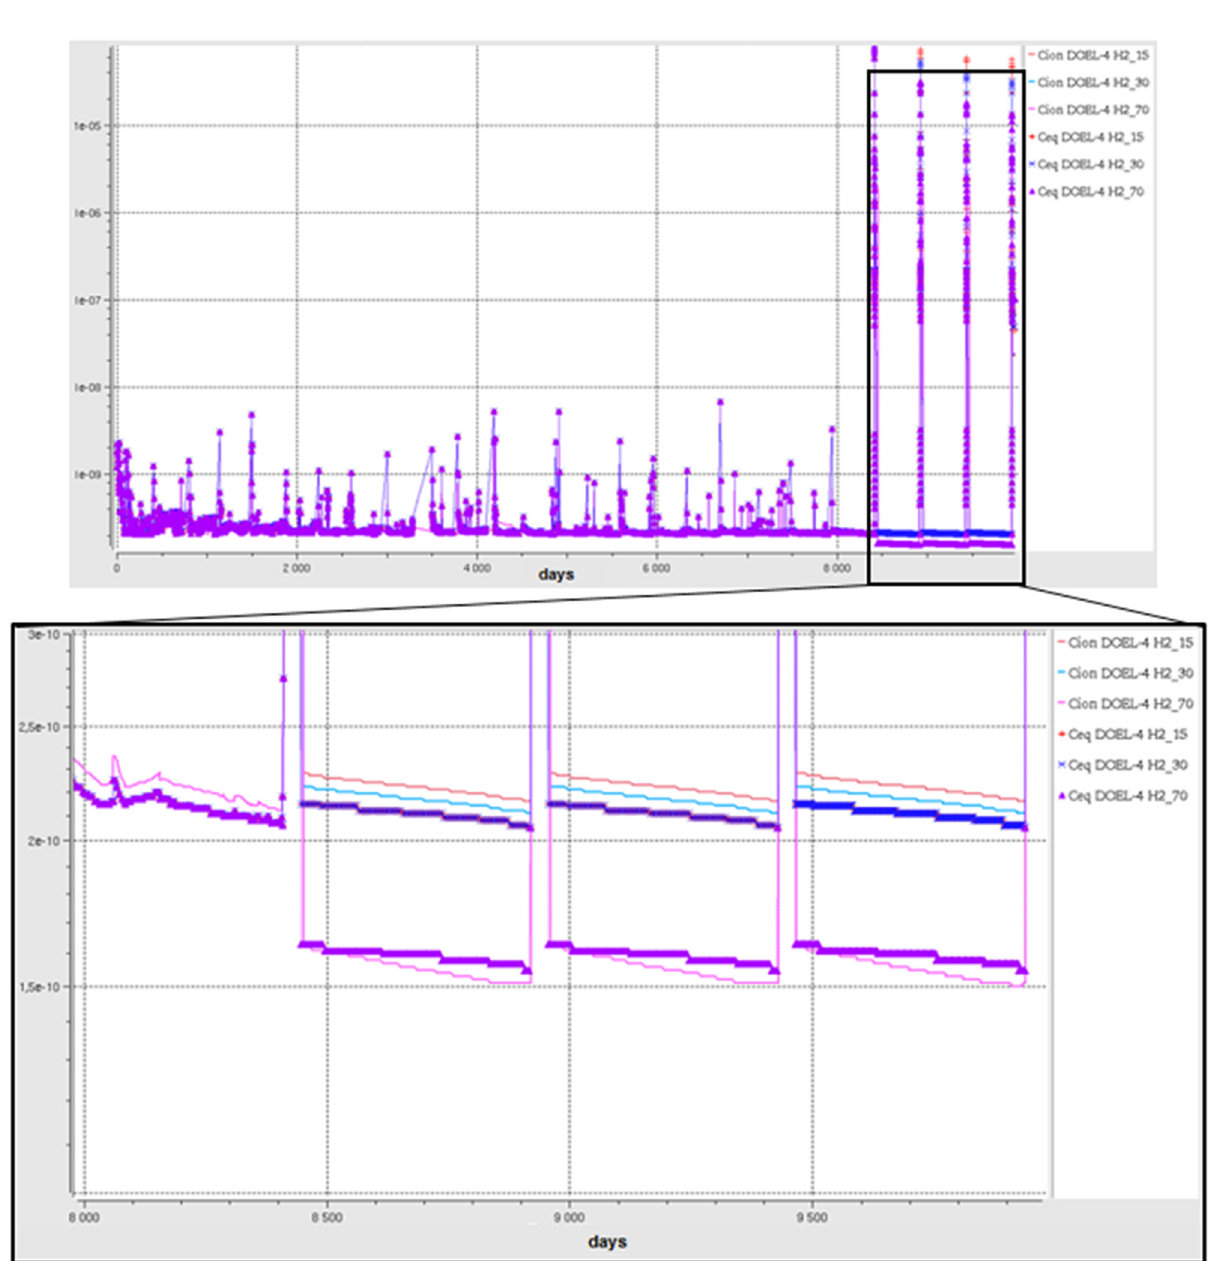
Fig. 8. OSCAR V1.3 calculation (cid:2) Comparison between Ni equilibrium concentrations in solution (Ceq) and Ni concentrations in solution (Cion) inside the hottest core region.